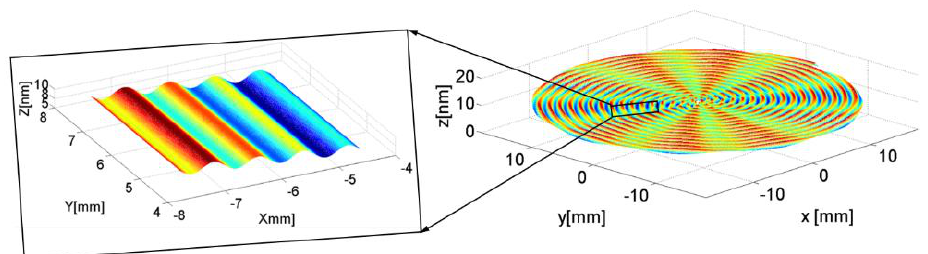
Figure 8. Structure diagram of the workpiece surface topography in cylindrical coordinate system.